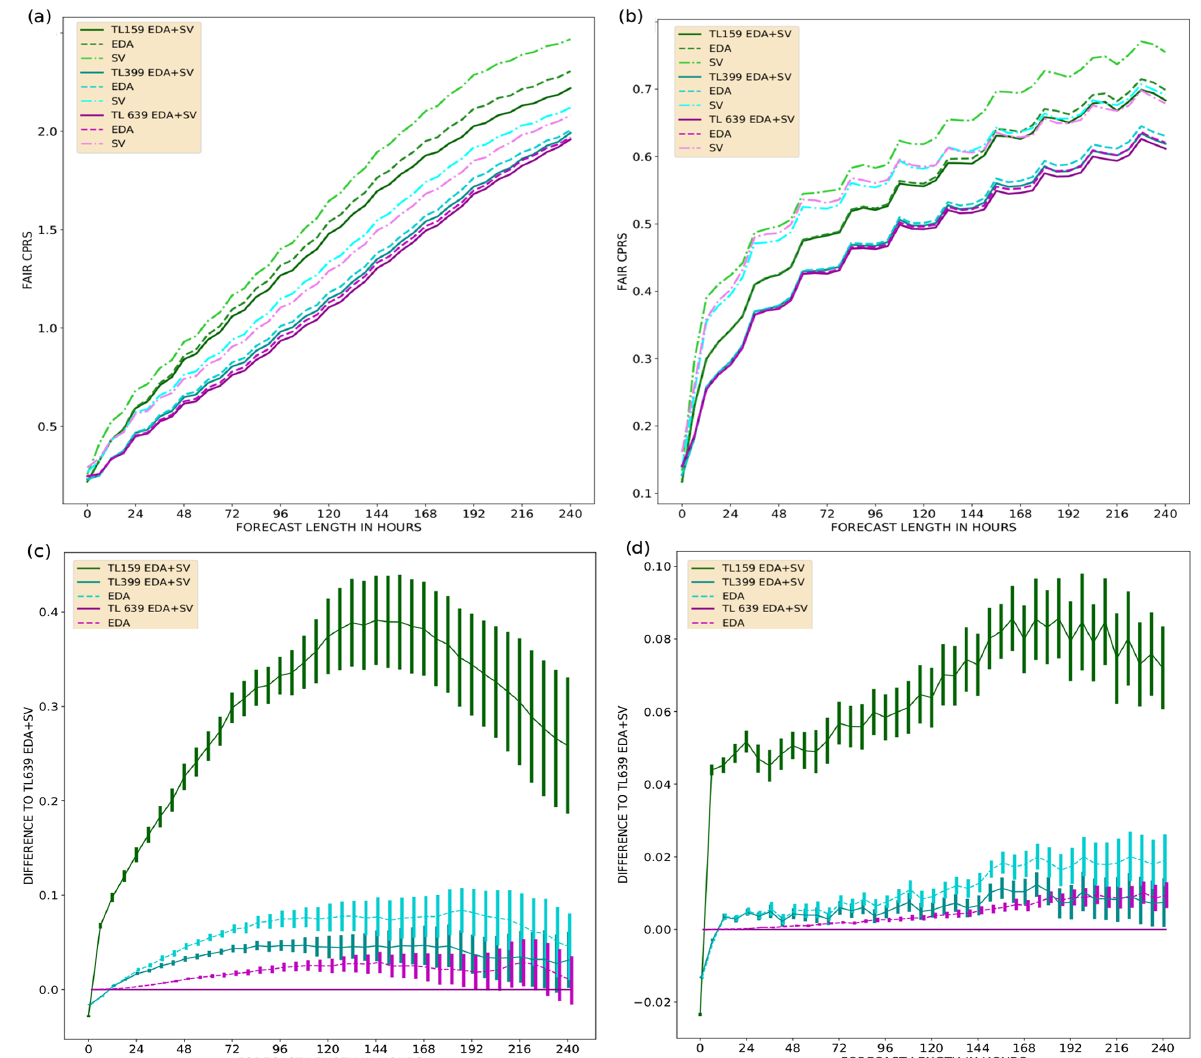
Figure 4. Fair CRPS as a function of forecast lead time, up to 240h, for the Northern Hemisphere (a) and the tropics (b) . The mean is calculated over 46 start dates. Fair CRPS difference to the T L 639 EDA+SV experiment with 95% confidence intervals for the Northern Hemisphere (c) and the tropics (d) . Scores for eight-member ensembles with various resolutions and perturbation methods: T L 159 (green), T L 399 (cyan), T L 639 (violet), SV perturbations only (dot-dashed), EDA perturbations only (dashed), and both SV and EDA perturbations